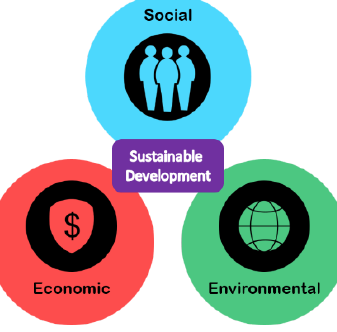
Figure 1. Triple Bottom Line